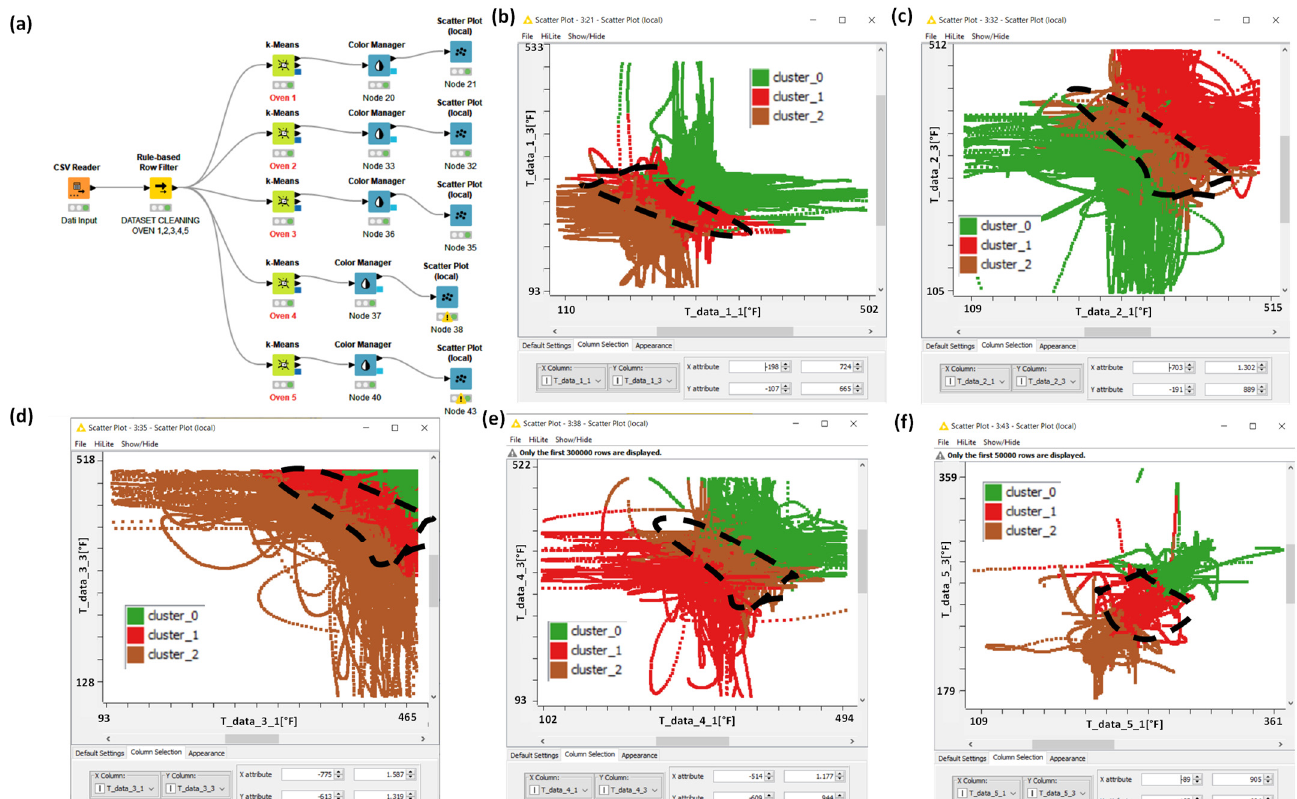
Figure A1. ( a ) KNIME workflow implementing unsupervised k-Means algorithm for oven data clustering. Couple of temperature variables and related data clustering (k = 3) for oven 1 ( b ), oven 2 ( c ), oven 3 ( d ), oven 4 ( e ), and oven 5 ( f ). The dashed black lines enclose the stable regions.